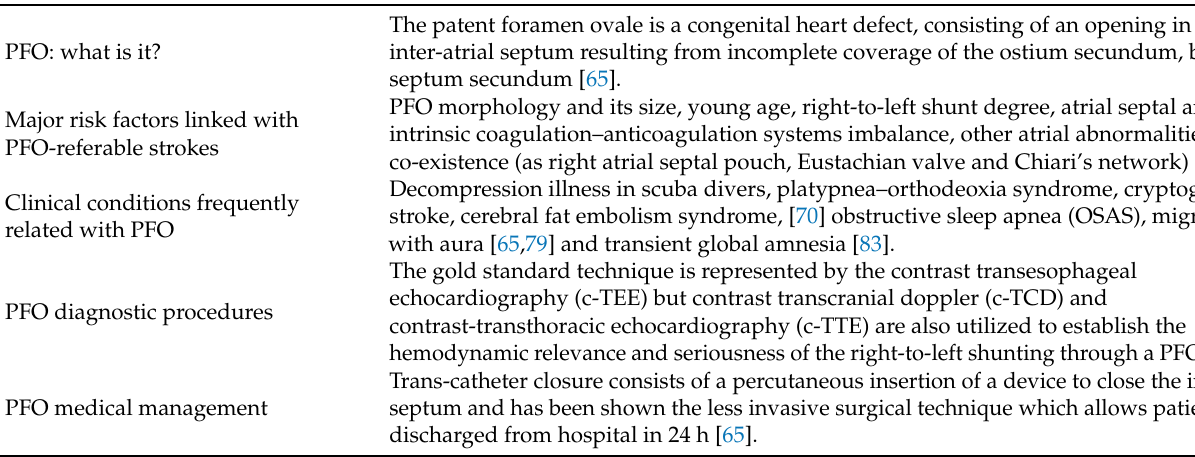
Table 2. Understanding the patent foramen